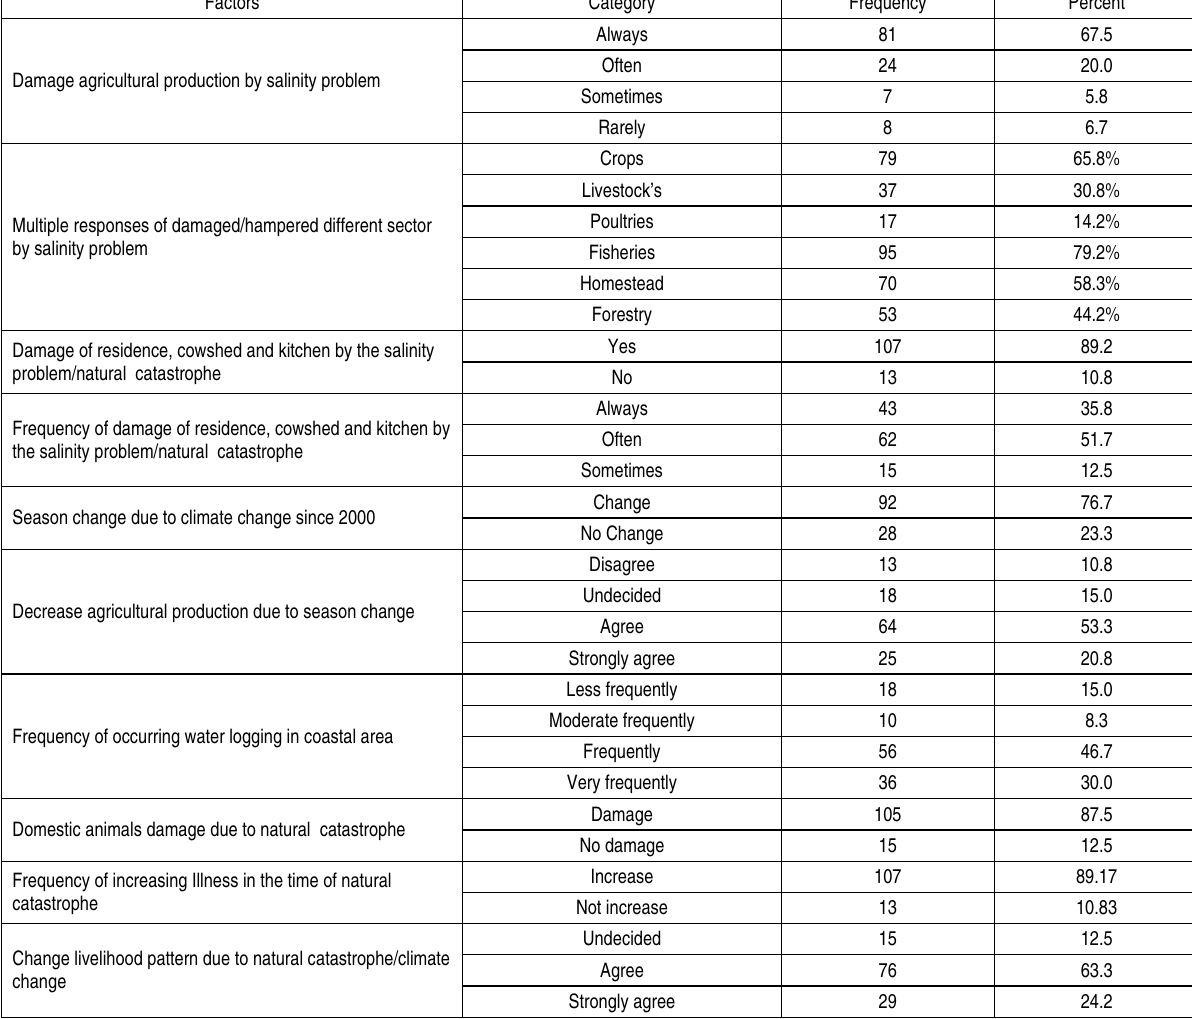
Table 1 (cont.). Demographic information with frequency level and